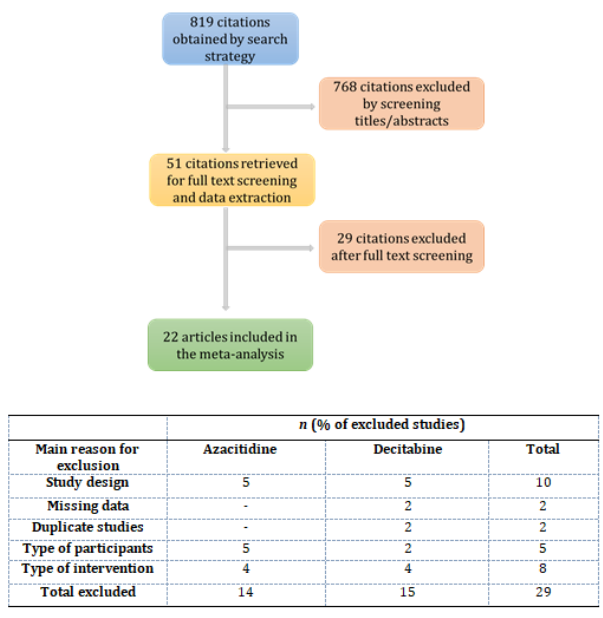
Figure 1. Flowchart of study selection procedure and the main reasons for article exclusion.